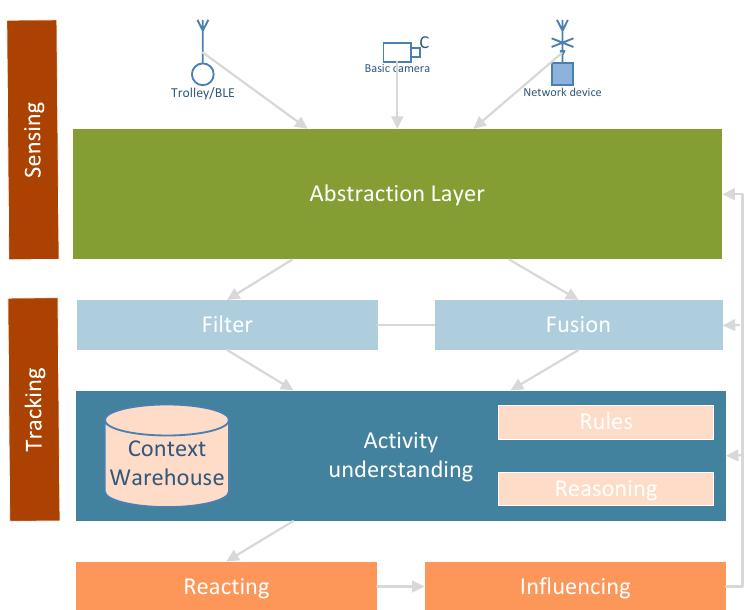
Figure 5. Basic system architecture for activity understanding and context reasoning, see also